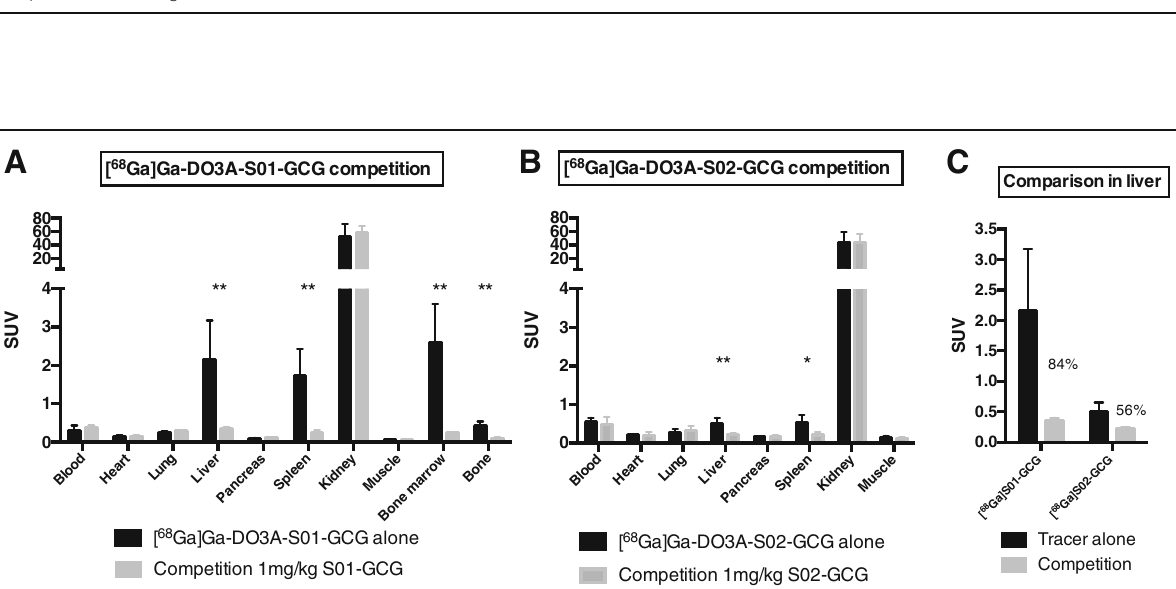
Fig. 4 In vivo biodistribution in rat of [ 68 Ga]Ga-DO3A-S01-GCG or [ 68 Ga]Ga-DO3A-S02-GCG. [ 68 Ga]Ga-DO3A-S01-GCG displayed rapid washout from most tissues with retention in GCGR-rich liver ( a ). The liver-to-blood ratio increased throughout 180 min ( b ). [ 68 Ga]Ga-DO3A-S02-GCG also exhibited retention in the liver but to a lesser degree ( c ). Similarly, the liver-to-blood ratio was less pronounced for [ 68 Ga]Ga-DO3A-S02-GCG as compared to [ 68 Ga]Ga-DO3A-S01-GCG ( d ). The biodistribution data was obtained from n = 2 animals for each time point. The bars in panels a and c represent the average of two animals